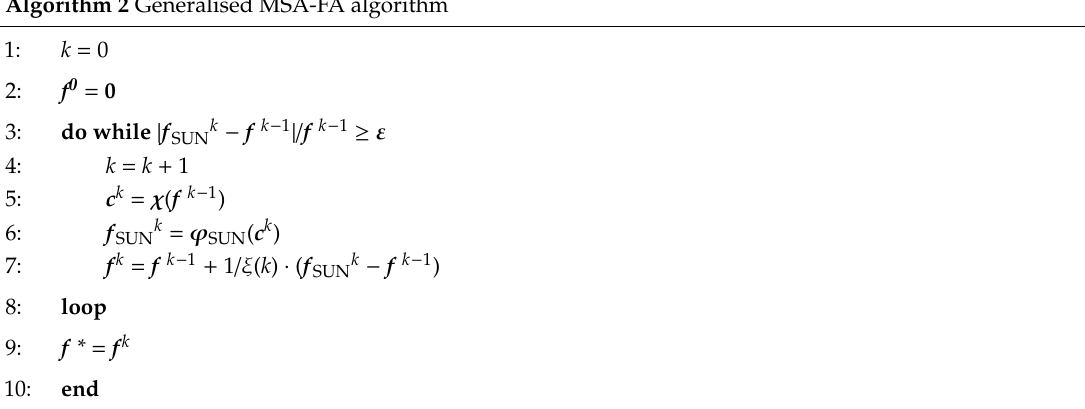
Algorithm 2 Generalised MSA-FA